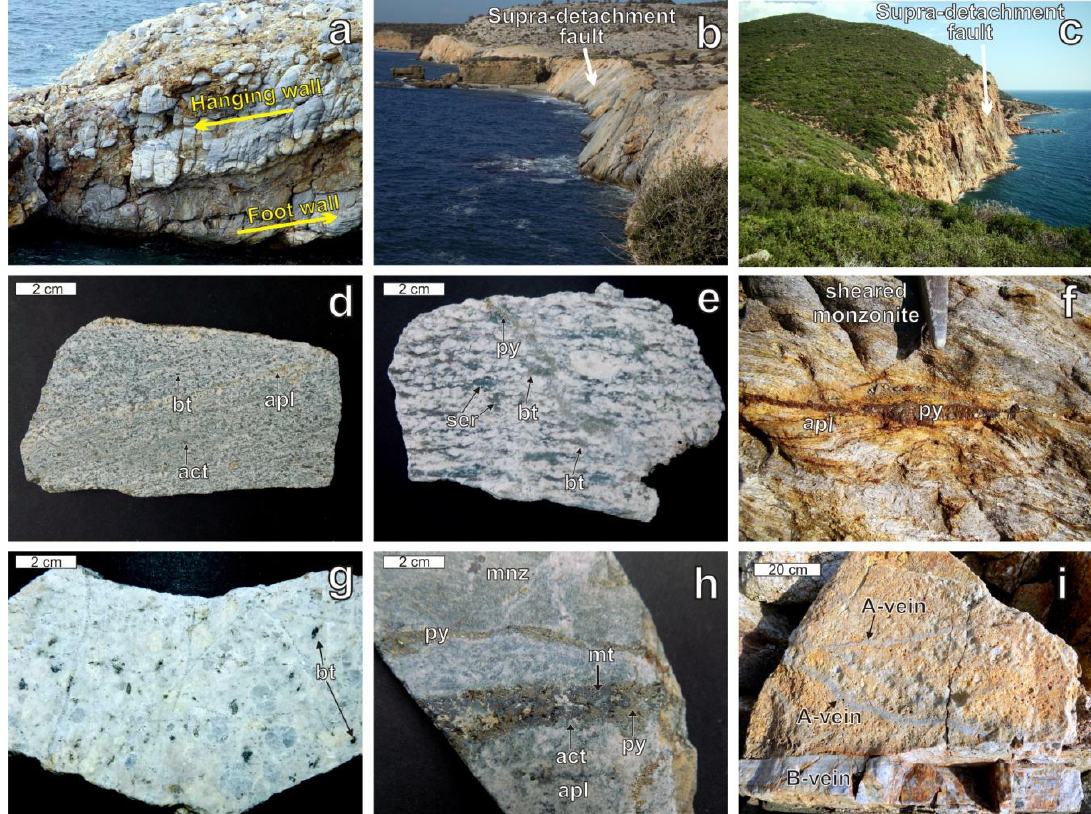
Figure 3. Photographs showing the structural control of the emplacement of the magmatic rocks, the potassic and sodic-calcic alterations with the associated mineralization and the various vein types. ( a ) The detachment fault is characterized by brecciation of the marble in the hanging wall and mylonitization of the calc-schist in the footwall (photographed towards SW); ( b ) High-angle supra-detachment normal fault in marble in the hanging wall of the detachment along the Aegean coast (photograph towards W); ( c ) High-angle supra-detachment normal fault along which the microgranite porphyry intruded (photographed towards E); ( d ) Sodic-calcic alteration consisting of hydrothermal actinolite (act) and biotite (bt) in highly strained and mylonitized monzonite, and an aplitic dike (apl) along the foliation; ( e ) Weak potassic alteration consisting of fine-grained hydrothermal biotite (bt) in highly strained microgranite porphyry, overprinted by strong sericitic alteration crosscut by a pyrite vein (py); ( f ) Mineralized aplitic dike (apl) that intruded mylonitized monzonite along the foliation; ( g ) Potassic alteration of the microgranite porphyry with secondary biotite (bt) at the south-eastern margin of the porphyry system; ( h ) M-type vein with hydrothermal magnetite (mt) and actinolite (act) associated with the sodic-calcic alteration in the sheared monzonite (mnz) and the aplitic dike (apl). Pyrite (py) (D-type vein) formed due to the re-opening of the vein during later sericitic alteration; ( i ) Barren A-type uninterrupted sinuous quartz veins associated with potassic alteration crosscut by a B-vein with pyrite-molybdenite mineralization in the microgranite porphyry. Features that characterize the Maronia detachment include brecciation of the marble in the upper plate of the hanging wall, mylonitization of the calc-schist of the lower plate in the footwall (Figure 3a), and the listric and planar high-angle supra-detachment normal faults that a ff ected metamorphic